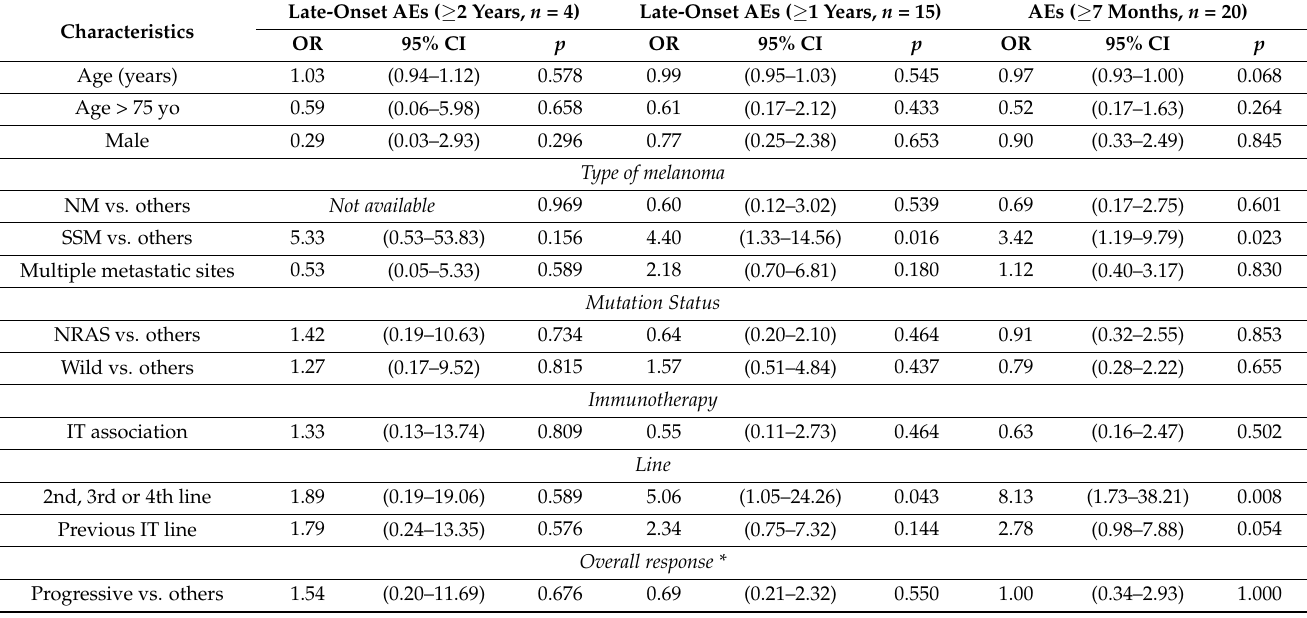
Table 4. Factors associated with late-onset events (7 months, 1 year, 2 years) by univariate analysis ( n : number of patients with AEs at that time point; OR: odds ratio; 95% CI = l: 95% confidence interval; p : p -value for univariate logistic regression).